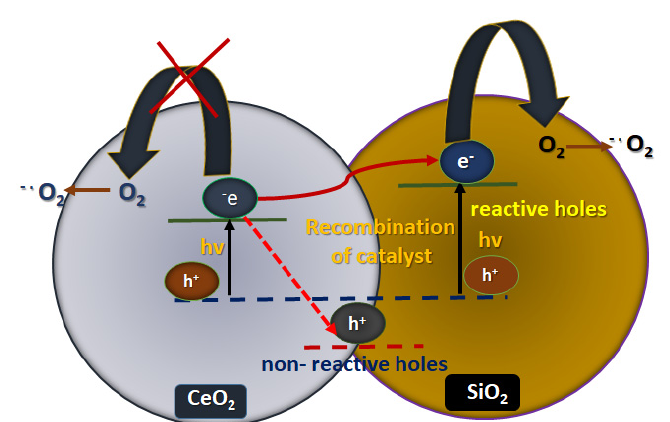
Fig. 13. Photodegradation Mechanism for wastewater dye using CeO